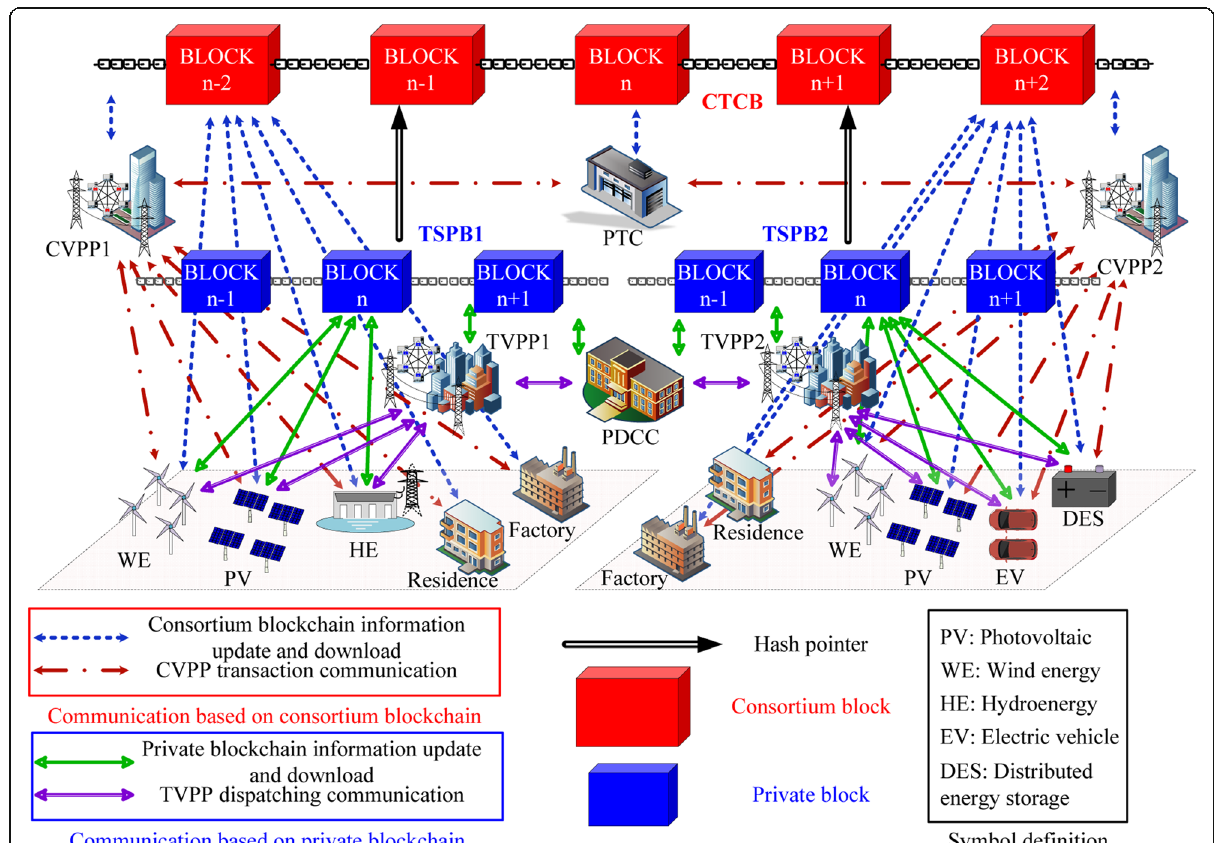
Fig. 3 VPP data storage and sharing system based on dual